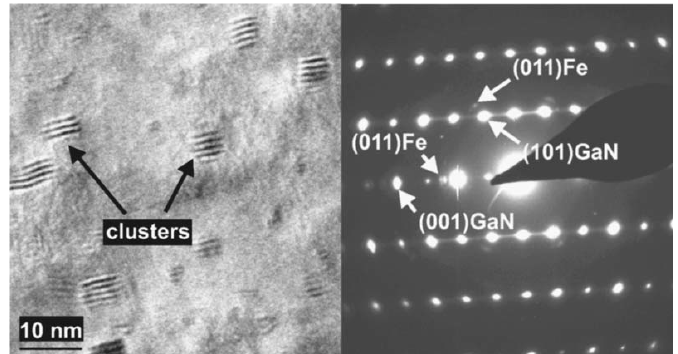
Figure 5. Fe nanoclusters epitaxially embedded in a p -GaN sample after an implantation of 4 × 10 16 Fe + ions and subsequently annealed to 800 ◦ C. Left side: HRTEM, and right side: the corresponding SADP. Reproduced with permission from Reference [58].